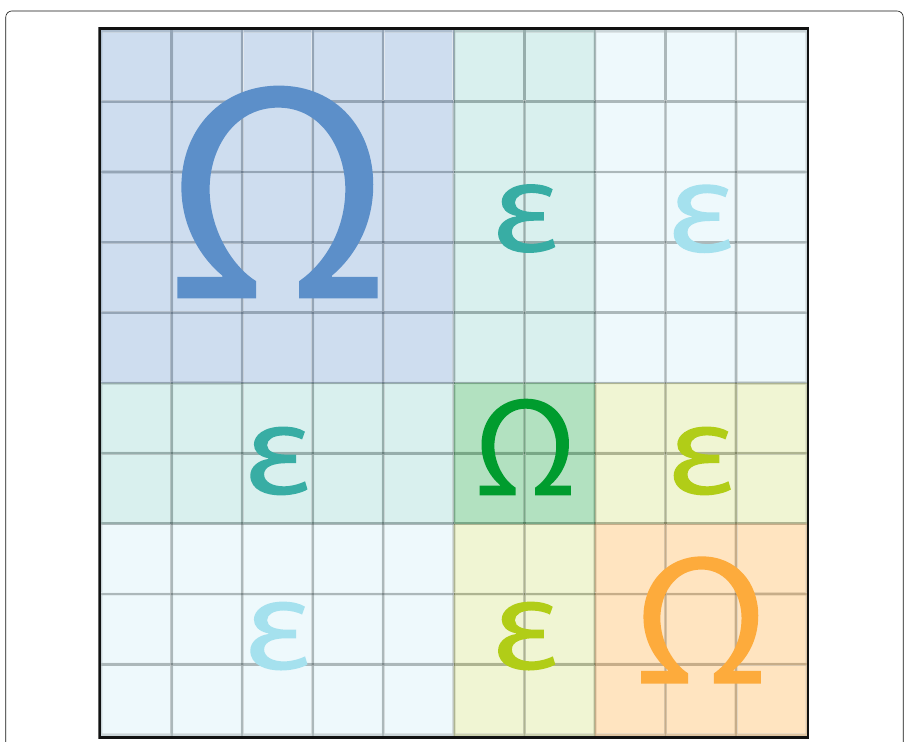
Fig. 2 Block-matrix. Structure of a block propensity matrix with 3 different blocks (blue, green, yellow). The entries along the diagonal capture the within-block propensities, those away from the diagonal capture the between-block